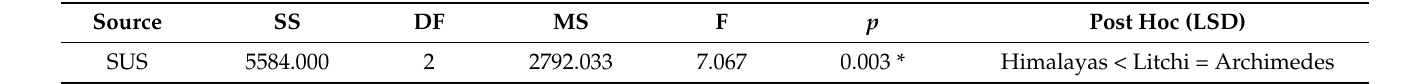
Table 4. The one-way ANOVA result of SUS